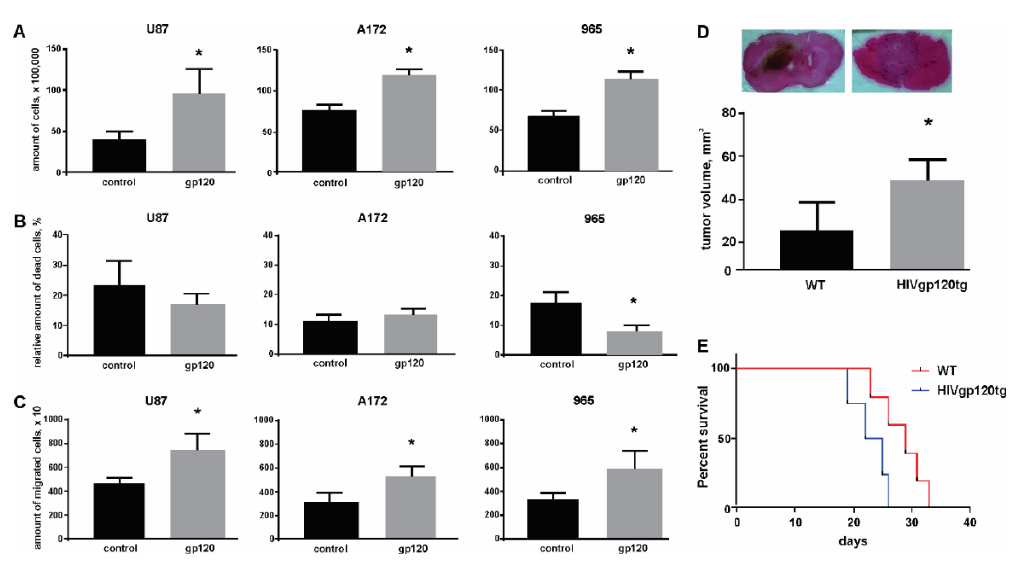
Figure 1. gp120 stimulates viability and migration and reduces cell death in glioma cells. Experiments were performed for untreated glioma cells and cells continuously treated with gp120 for 10 days. U87 and A172 cell lines and 965 primary glioma cells were investigated. Live and dead cells were counted with the use of trypan blue staining. ( A ) Cell viability was evaluated as the total number of live cells. ( B ) The proportion of dead cells was evaluated as the percentage of the total number of cells. ( C ) Migration assays were performed using Transwell membranes for 5 h of migration toward 5% serum-containing medium in the lower compartment. The total number of cells that had migrated to the lower compartment was determined and is represented in the graph. ( D ) H&E staining of brain sections encompassing glioma tumor and quantification of tumor size in wild type (WT) and HIVgp120tg mice. ( E ) Survival analysis, performed for WT and HIVgp120tg mice following GL261 glioma cells implantation. Mean ± S.E. and significant differences from control (*) are shown ( p < 0.05). Unpaired t -tests were used to determine the significance between groups. Comparison of survival curves was performed by use of long-rank Mantel-Cox test. Six repeated experiments ( n = 6) were used for statistical analysis.